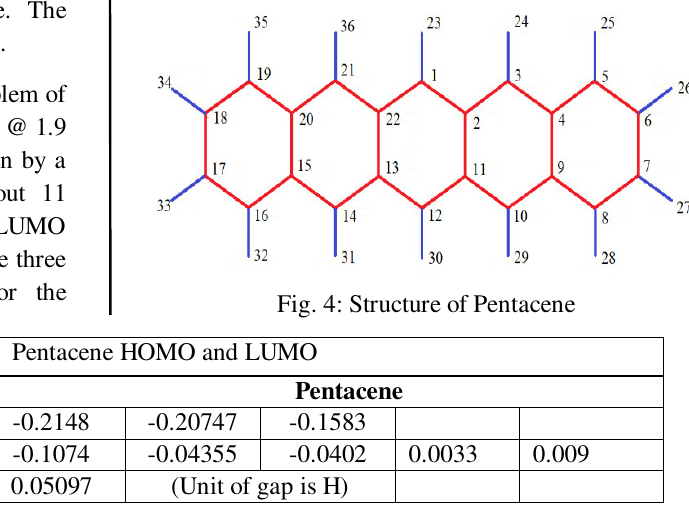
Table 3: Coordinates of Pentacene